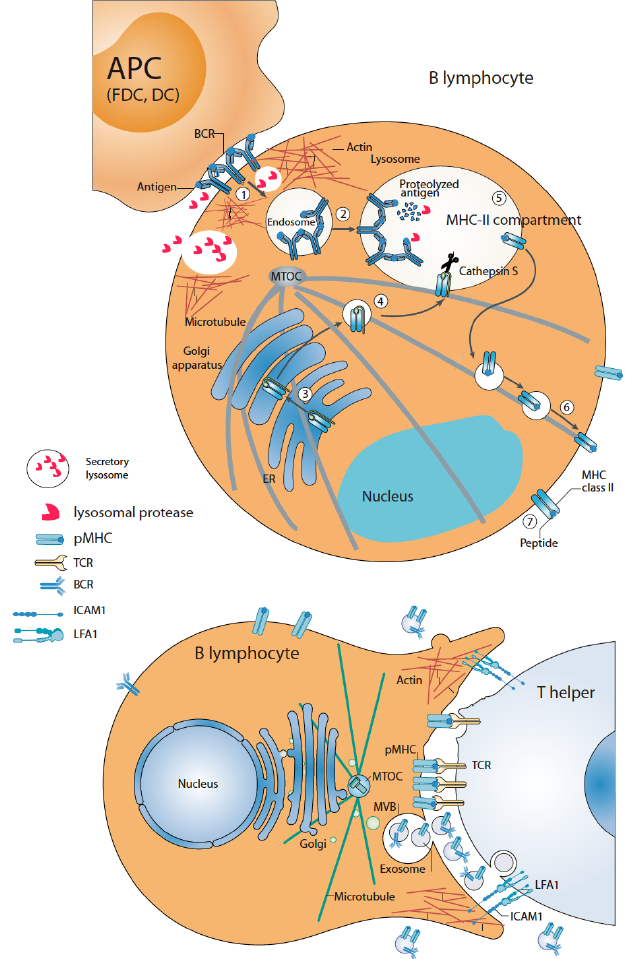
Figure 3. B lymphocytes form two classes of IS: antigen ‐ capture/processing (upper panel) and antigen presentation to Th lymphocytes (lower panel). Upper panel, antigen recognition on APC is mediated by B ‐ cell receptors (BCR). BCR triggering induces actin reorganization at the IS and MTOC and secretory lysosomes recruitment towards the IS and protease secretion at the extracellular synaptic cleft, facilitating antigen processing and extraction. Subsequently, antigen ‐ BCR complexes are extracted and endocytosed in a clathrin ‐ dependent process to early endosomes (stage 1) and, then to late endosomal, MHC ‐ II + compartments (stage 2) where antigen and MHC ‐ II molecules trafficking from Golgi (stages 3 and 4) converge. Coordinately with antigen endocytosis, antigen ‐ BCR interaction promotes the biogenesis of this compartment to facilitate antigen processing. In this compartment, the antigen is additionally processed by proteases to form MHC ‐ II/antigenic peptide complexes (pMHC ‐ II) (stage 5) that, subsequently, are exported and distributed to the cell surface (stages 6 and 7). Lower panel, pMHC ‐ II complexes are recognized by Th lymphocyte TCR forming a second secretory IS. This leads to a polarized phenotype leading to MTOC and MHC ‐ II + compartment (MVB) polarization. Local secretion of exosomes containing pMHC ‐ II complexes at the B lymphocyte IS side is represented (see text for further details).